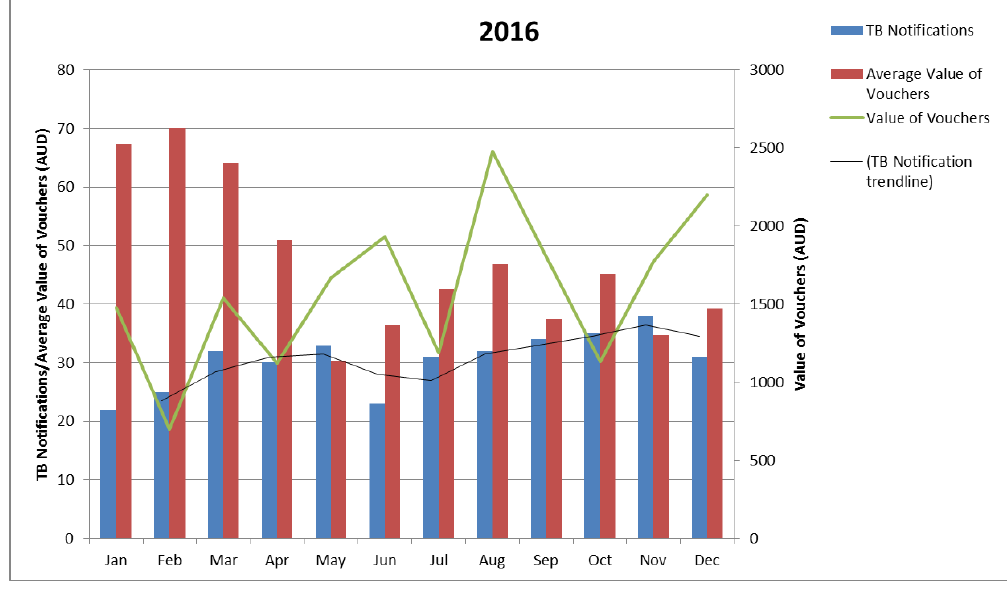
Figure 2. Value of Vouchers Provided by Month, 2016.